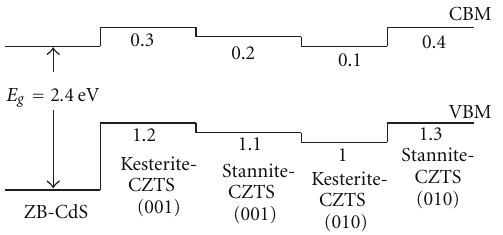
Figure 6: Band alignments of CdS and di ff erent crystal structures of CZTS (kesterite and stannite) with (001) and (010) orientations.